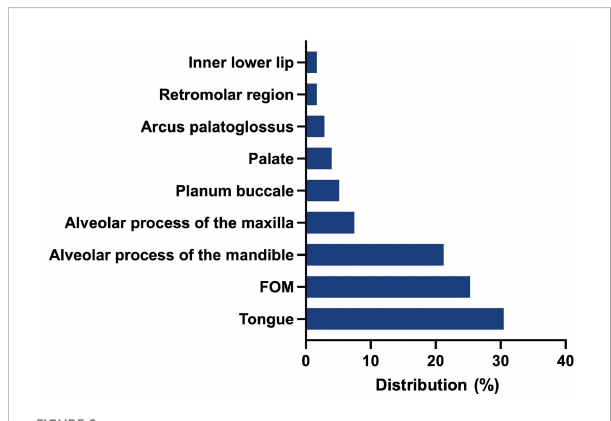
FIGURE 2 Frequency of primary localizations: Tongue was the most frequent localization (30.46%), followed by fl oor of mouth (FOM) with 25.29%, alveolar process of the mandible (21.26%), alveolar process of the maxilla